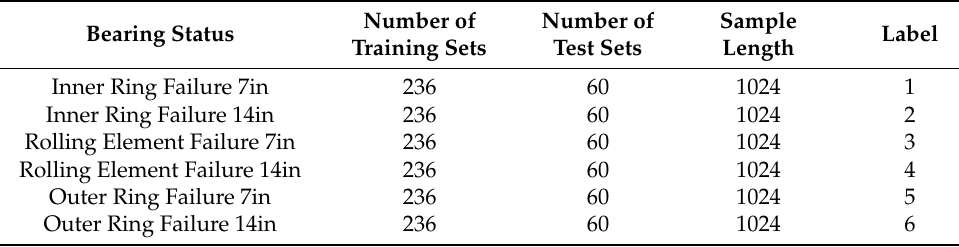
Table 7. Description of the samples obtained from the CWRU dataset.